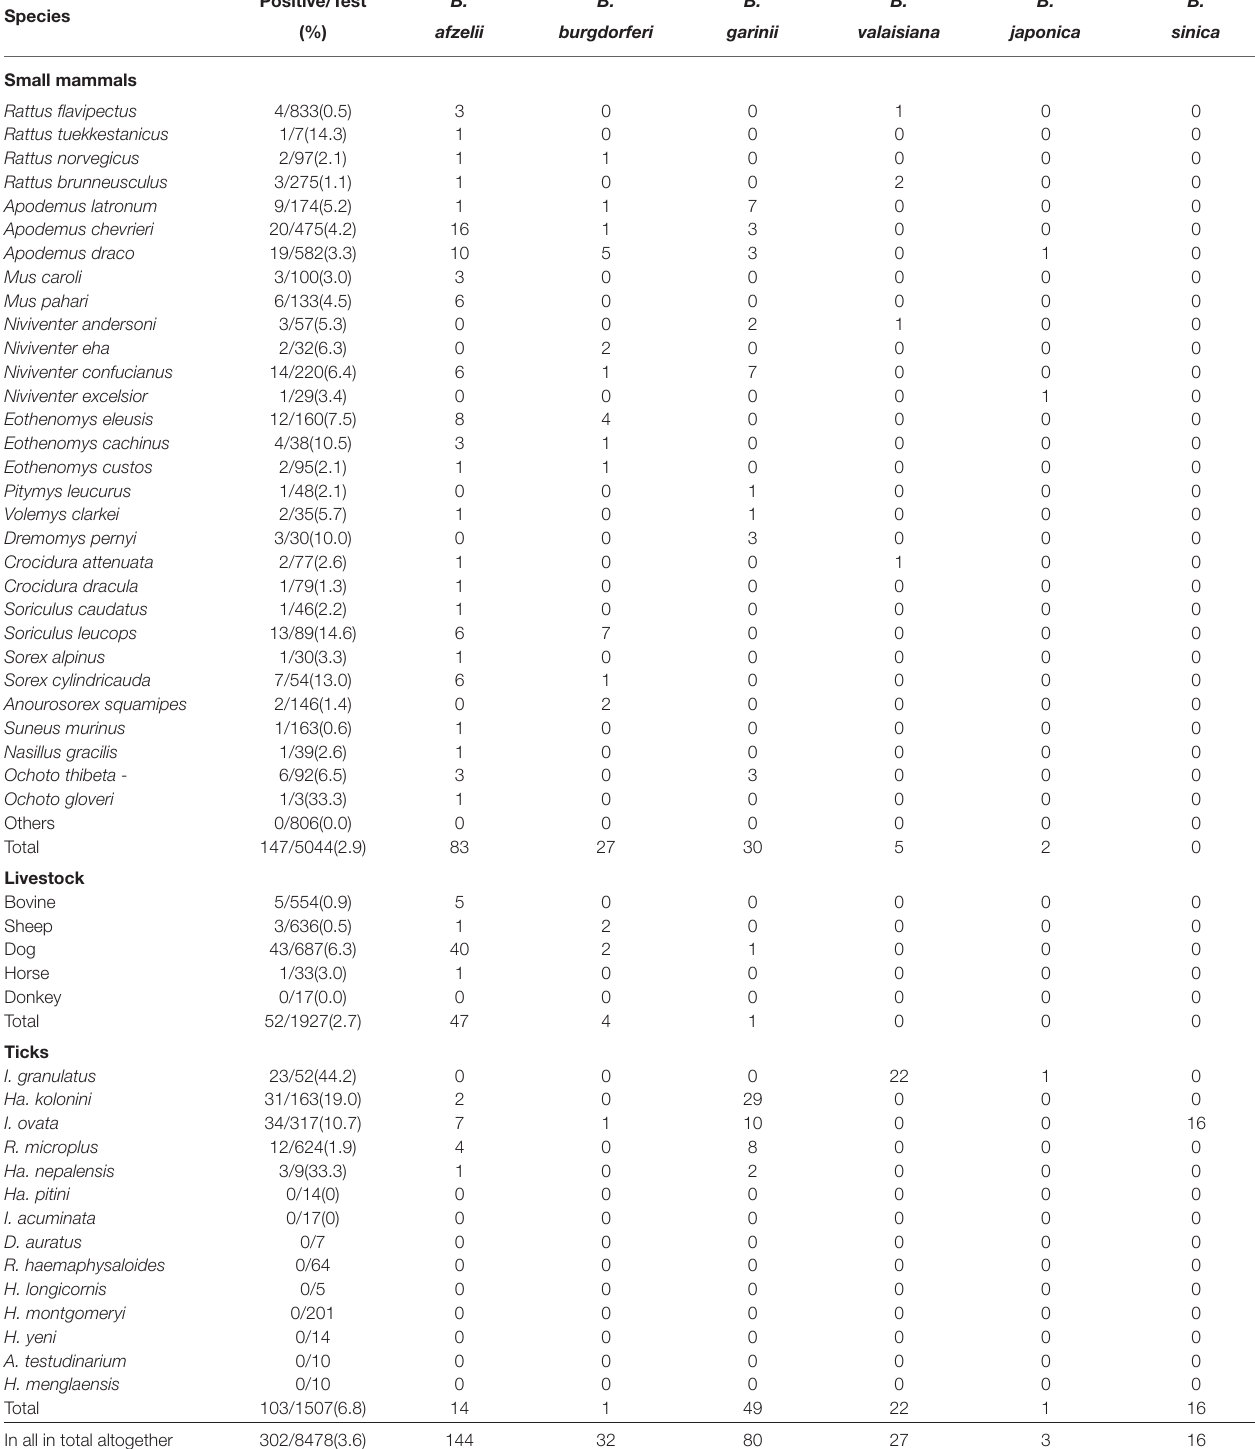
TABLE 2 | Prevalence of Borrelia burgdorferi sensu lato in different species.